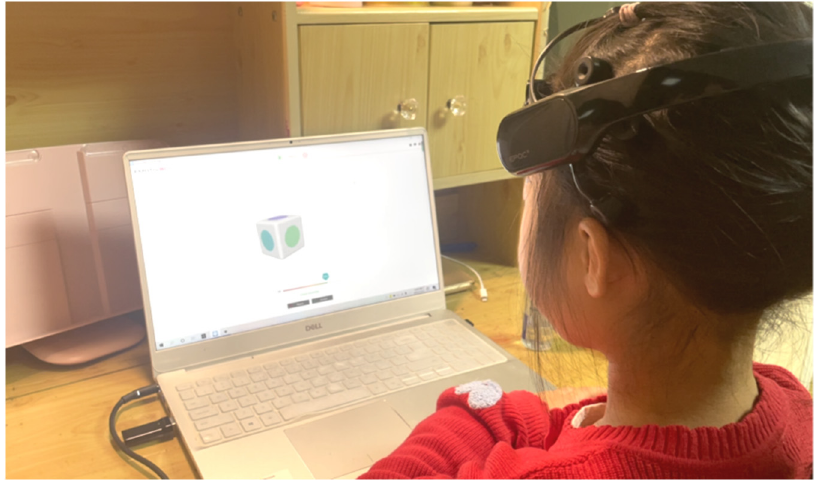
Figure 14. EEG command training.